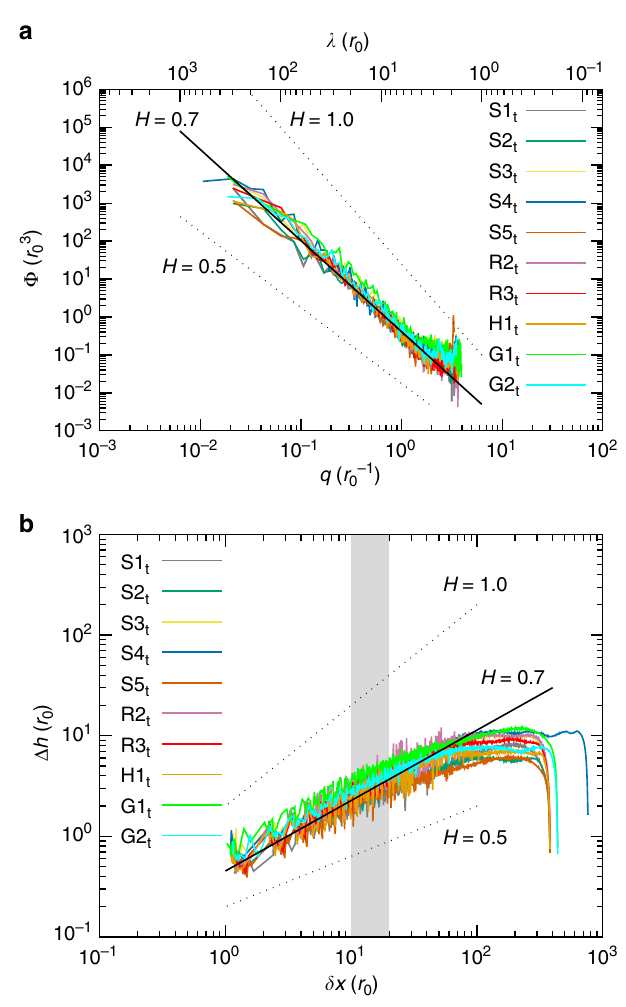
Fig. 2 Steady-state surface morphology analysis. a PSD per unit length Φ as a function of the wavevector q and the wavelength λ , the relation between the two being q = 2 π / λ . b Height – height correlation function D E 1 = 2 Δ h ð δ x Þ ¼ h ð x þ δ x Þ (cid:4) h ð x Þ½ (cid:5) 2 . The surfaces are taken from ten different simulations (see Table 1 for details), the subscript indicates the top surface for each simulation. Bottom surfaces for the same simulations are reported in Supplementary Fig. 1. In both a and b , the solid black straight guide-line corresponds to a Hurst exponent H = 0.7. Dotted black straight guide-lines show the hypothetical slope for distributions of H = 0.5 and H = 1.0. In b , the shaded area displays the interval of distances corresponding to the range of critical length scale values d * exhibited by the adopted potentials. No pronounced crossover is observed in the slope of Δ h ( δ x ) over the range of values for d * . As a consequence of the assumption of periodic surfaces, the function is roughly symmetric with respect to half the horizontal box size (hence the plateau and the following drop for large values of δ x